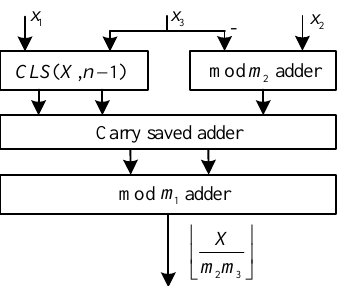
Figure 5. Optimized scaling structure for scaling factor m 2 m 3 .